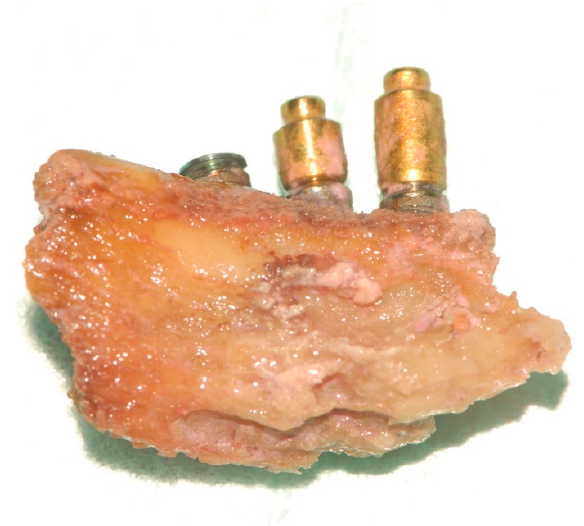
Figure 3. Macroscopic aspect of the detached necrotic bone fragment that includes the implants.